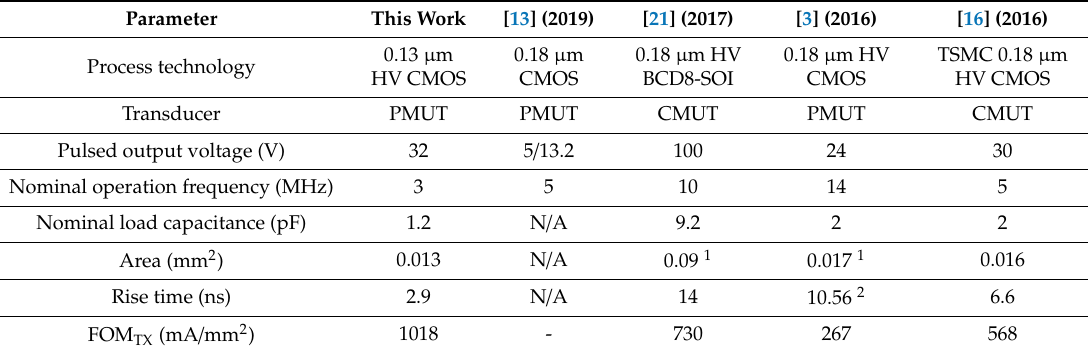
Table 2. HV transmitter performance summary and